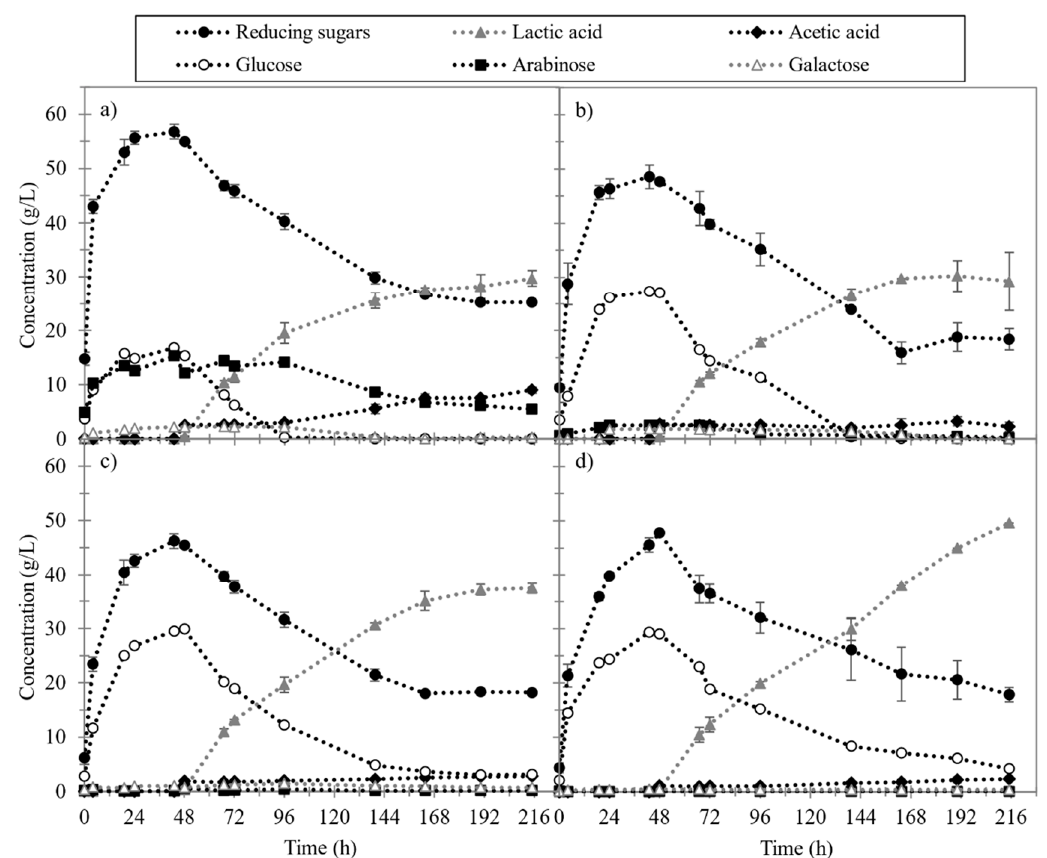
Figure 3. Enzymatic hydrolysis and lactic acid fermentation of thermochemical pretreated ESBP at sulphuric acid con- centration of 0% ( a ), 0.25% ( b ), 0.5% ( c ) and 1% w / v H 2 SO 4 ( d ): reducing sugars concentration (black circle), lactic acid concentration (grey triangle), acetic acid concentration (black diamond), glucose concentration (white circle), arabinose concentration (black square) and galactose concentration (white